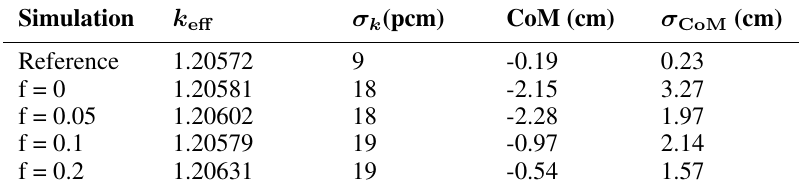
Table 2: Results for the vacuum-boundary PWR